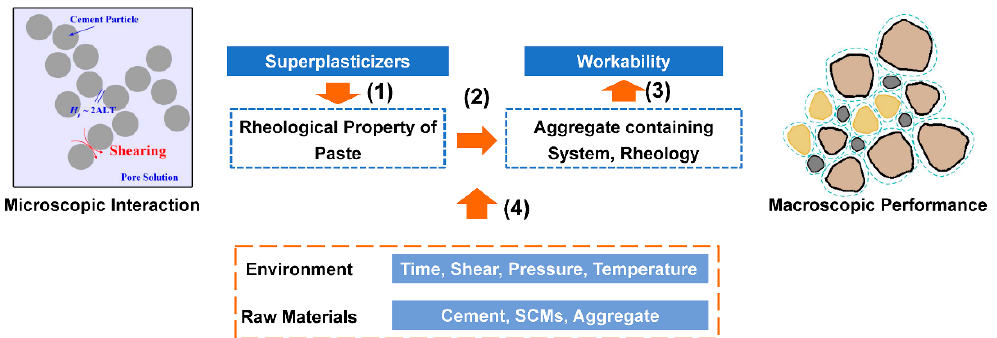
Figure 1. The four aspects (orange arrows represent the relationships) to elucidate the effects of chemical admixtures on concrete workability.